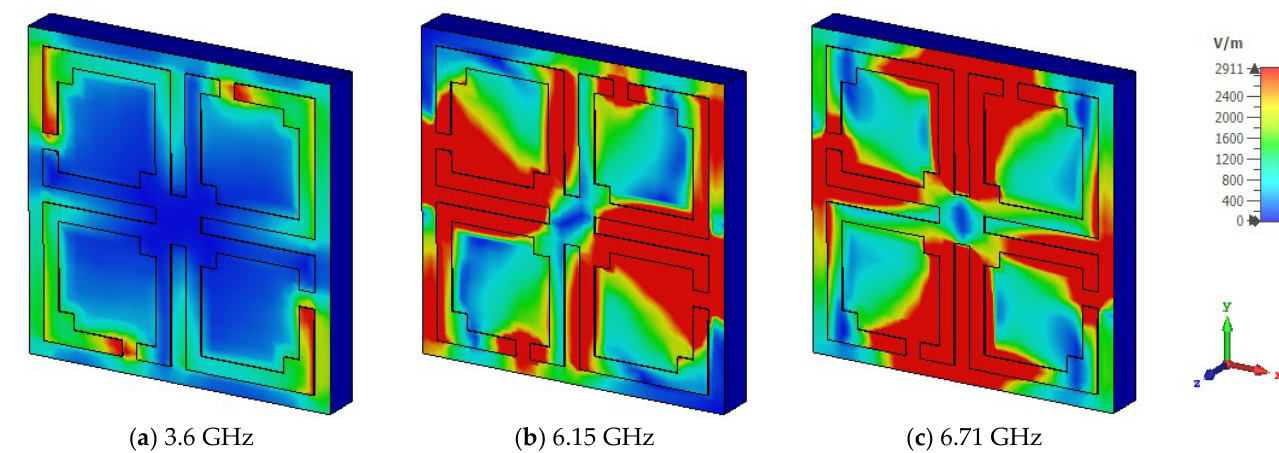
Figure 8. Electric field distribution of MM structure at three different resonance frequencies.